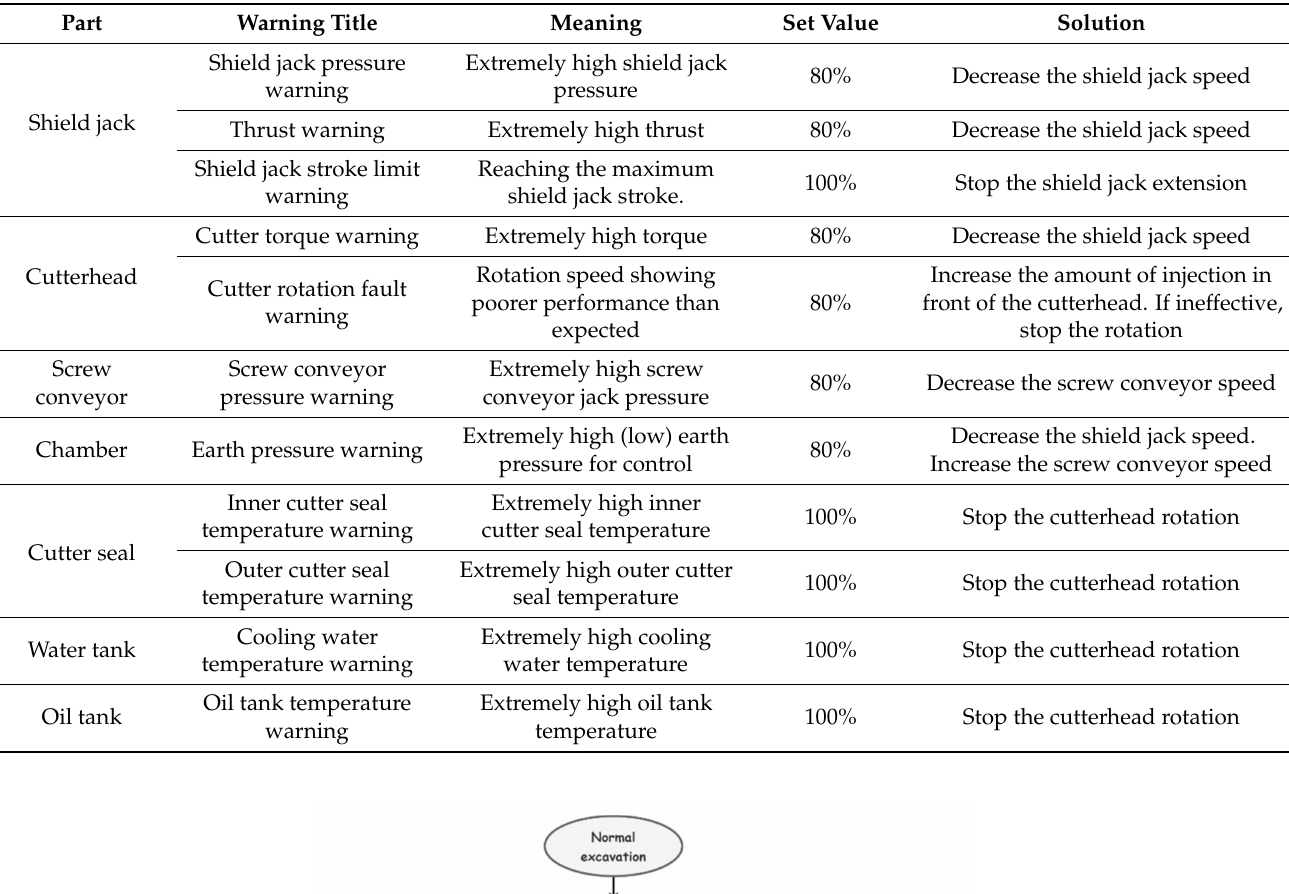
Table 6. Summary of warning systems and countermeasures in the TBM simulator.